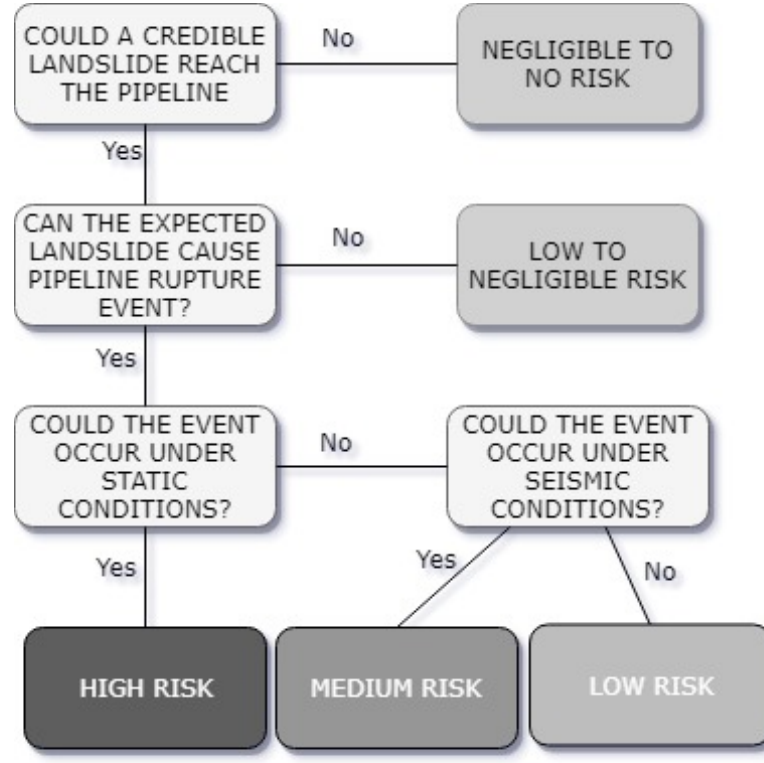
Figure 16. Landslide risk model employed developed in the present work.